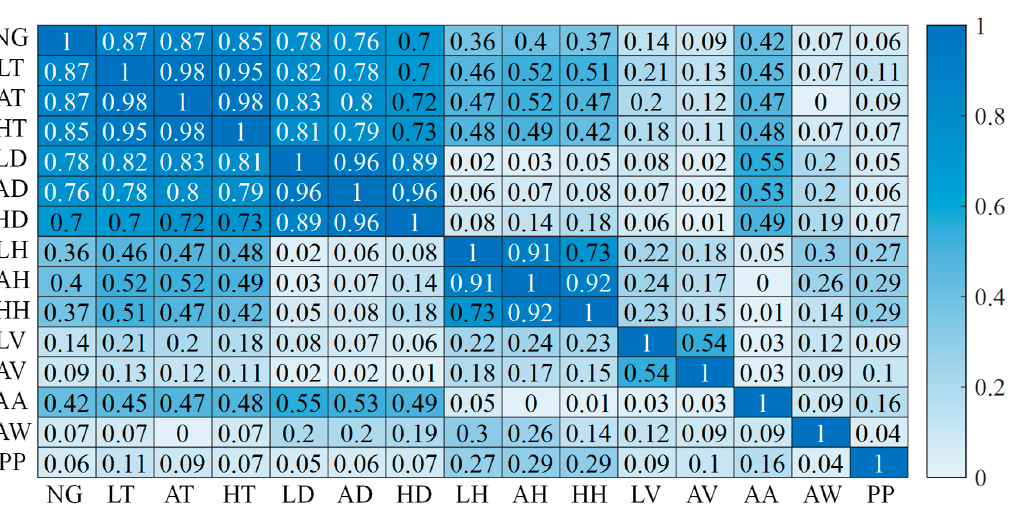
Figure 9. The absolute correlation coefficient between the factors of the Athens case.